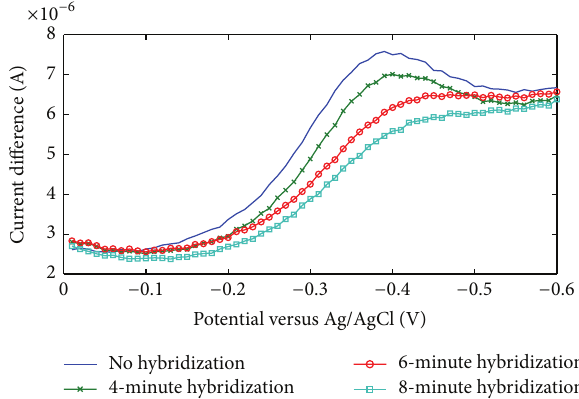
Figure 14: Square wave voltammetric detection of DNA hybridiza- tion.